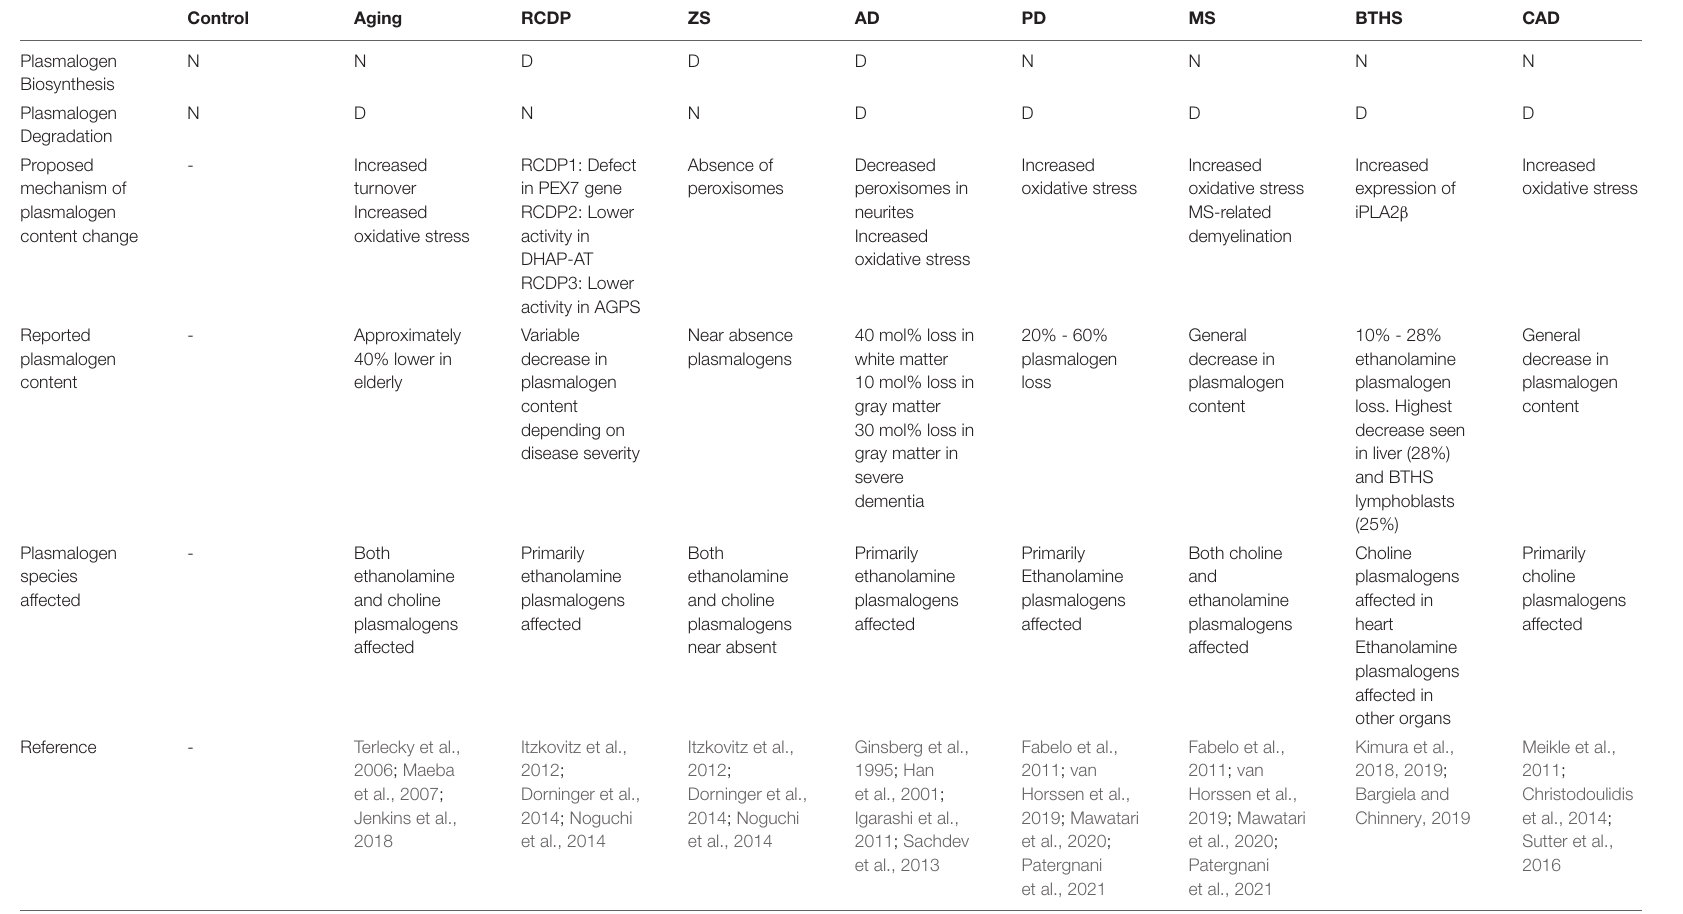
An outline of different pathophysiological conditions where plasmalogens levels have been reported to be decreased and the proposed effect on plasmalogen biosynthesis, degradation, and mechanism of plasmalogen content change. RCDP, Rhizomelic chondrodysplasia punctata; ZS, Zellweger’s syndrome; AD, Alzheimer’s disease; PD, Parkinson’s disease; MS, Multiple sclerosis; BTHS, Barth syndrome; CAD, Coronary artery